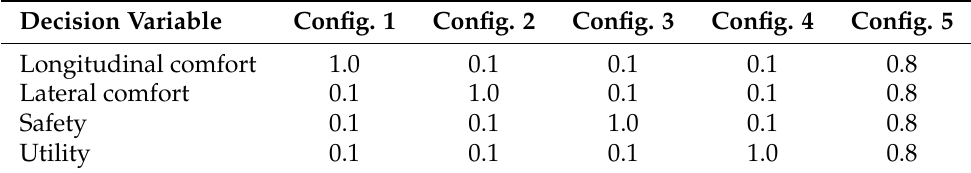
Table 3. Weight configurations of the decision variables for different experiments.